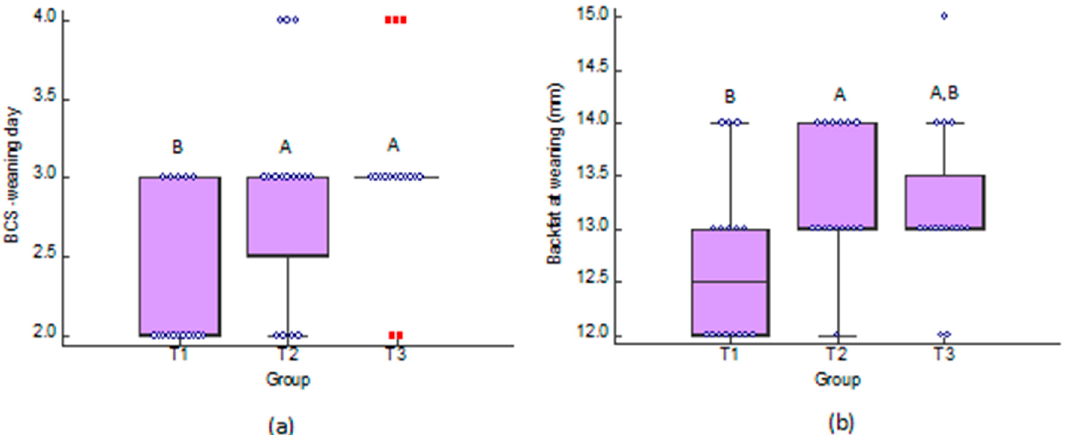
Figure 4. Dot and box and whisker plots of: ( a ) body condition scoring (BCS) of sows at weaning day; and ( b ) the weaning to estrus interval, in control group (T1), group fed with Herb-All HEAT-A (T2) and group fed with Herb-All HEAT-D (T3). A,B Different letters above bars are indicative of significant difference ( p < 0.05).